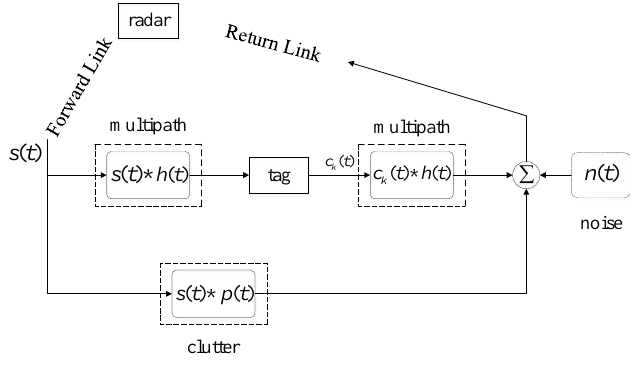
Figure 2. Continuous time signal model